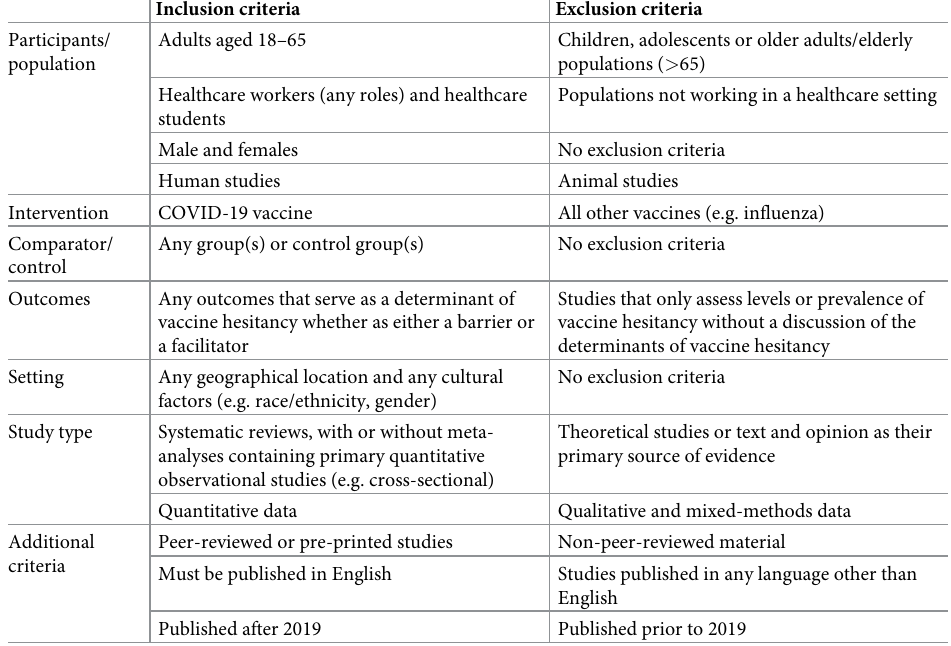
Table 1. Inclusion and exclusion criteria for eligibility in the review.